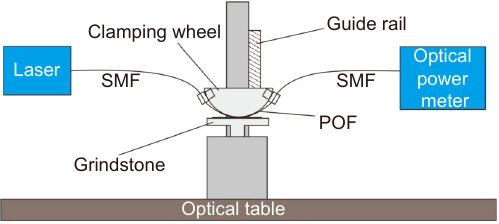
Fig. 4 | Schematic diagram of the experimental setup.